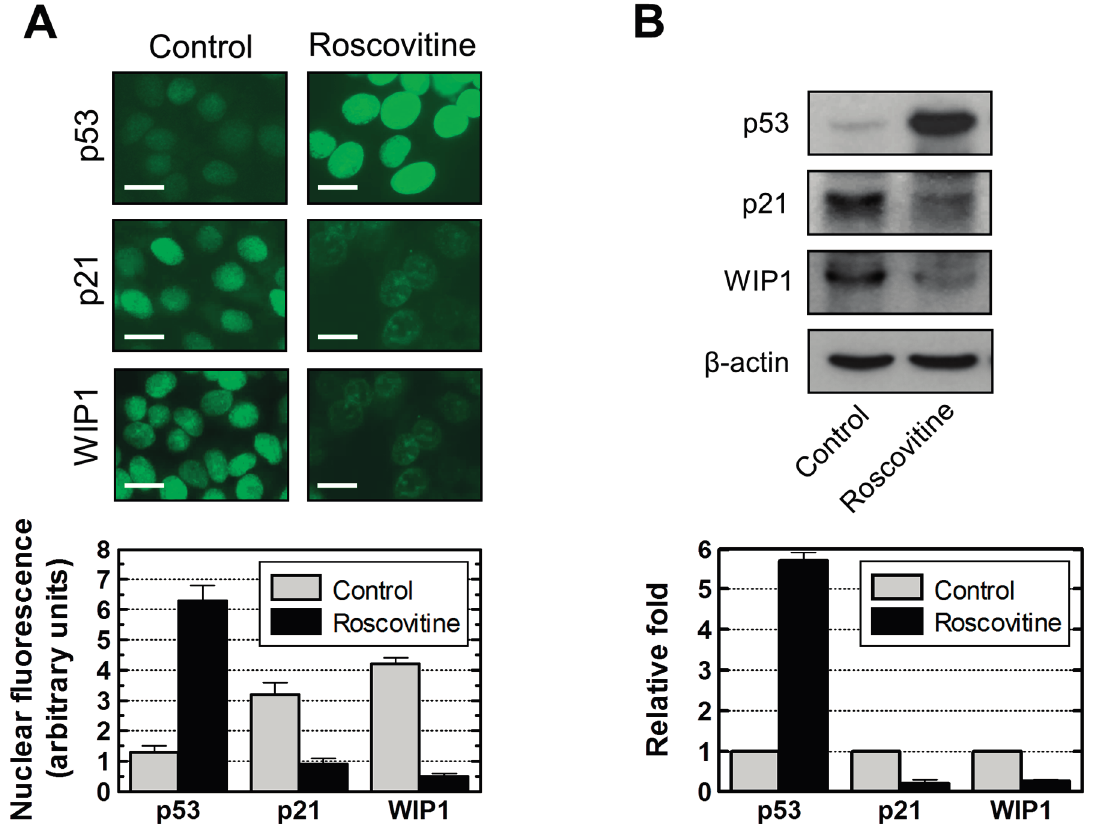
Figure 11. Influence of p21 downregulation by roscovitine (40 µM, 24 h) on p53 and WIP1 protein levels in MCF7 cells. ( A ) Immunofluorescence analysis of nuclear protein levels for control and roscovitine-treated cultures. The histograms for the indicated proteins were obtained from densitometric analysis of intensities of nuclear fluorescence staining from at least four coverslips; over 100 cells were evaluated for each coverslip. Bars, SE; Scale bar, 10 µm; ( B ) Immunoblot analysis of global protein levels before and after roscovitine treatment. The histograms for each protein were obtained from densitometric analysis of the band, normalized to actin, from at least three independent immunoblots. Bars,